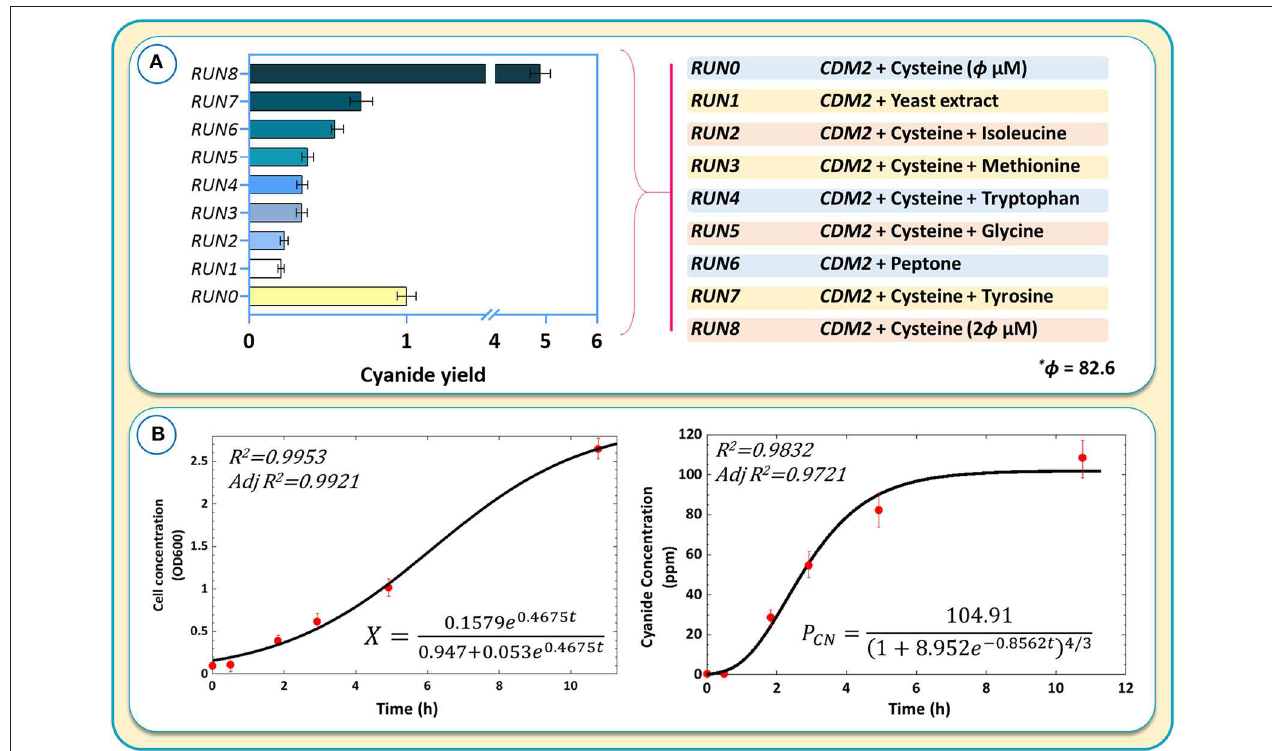
FIGURE 10 | (A) The results of cyanide production using different culture media and components of different culture media for cyanide overproduction. Cyanide yields are normalized with respect to the blank sample, RUN0 . (B) Kinetic modeling of cyanide production during the logarithmic growth phase.